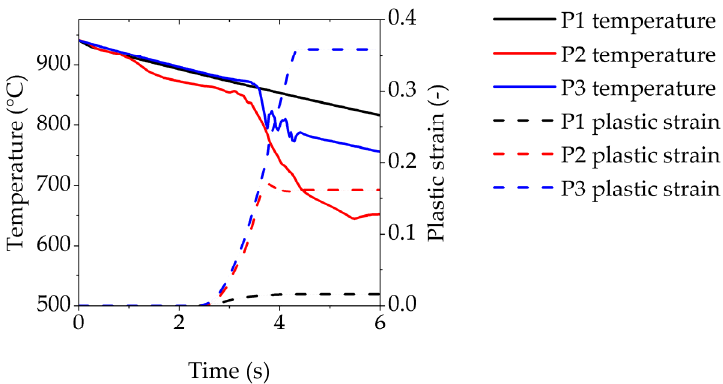
Figure 13. Local interaction between plastic strain and workpiece temperature at points 1, 2 and 3 of the cup for the X12Cr13 alloy from FE simulation after austenitization at 1050 °C and immediate transfer.